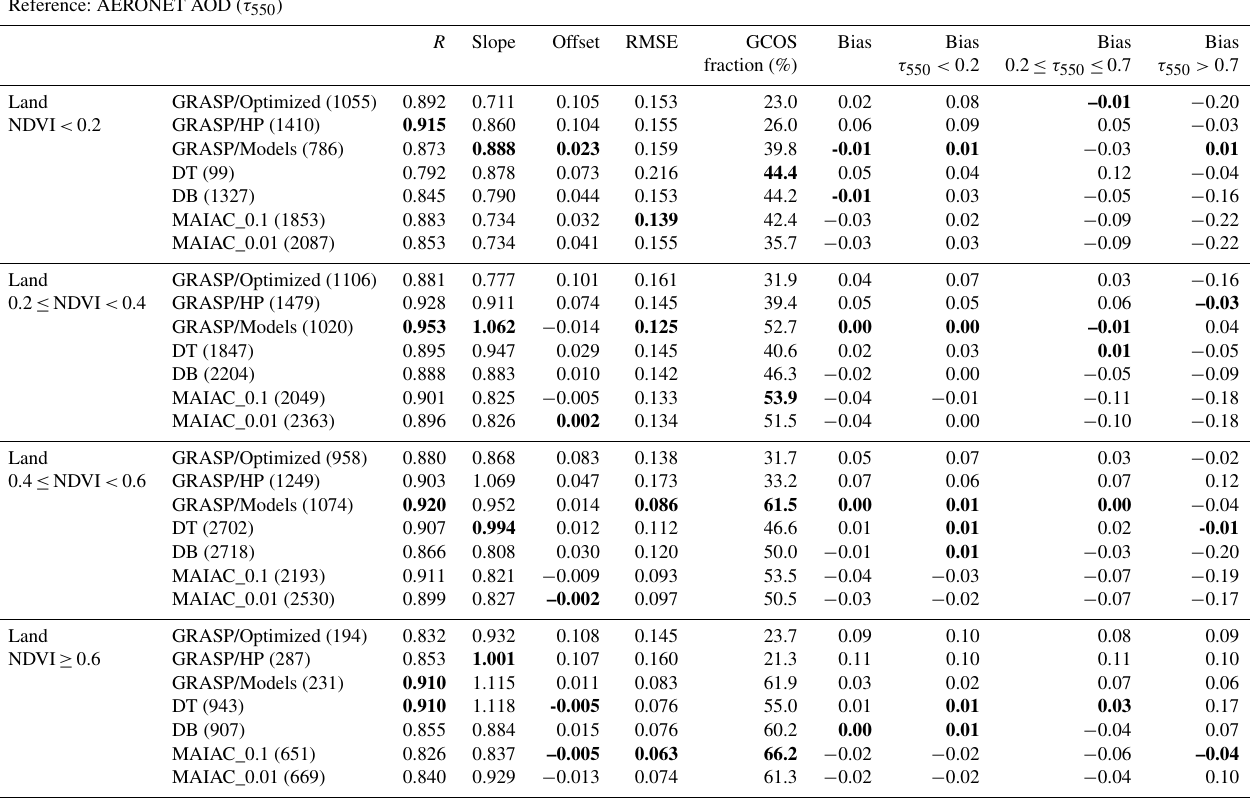
Table 10. Statistics of PARASOL and MODIS AOD products against collocated AERONET AOD at 550nm classified by NDVI. In each individual NDVI level, the best performing metric is indicated in bold. The number of matched pairs is included in brackets. Reference: AERONET AOD ( τ 550